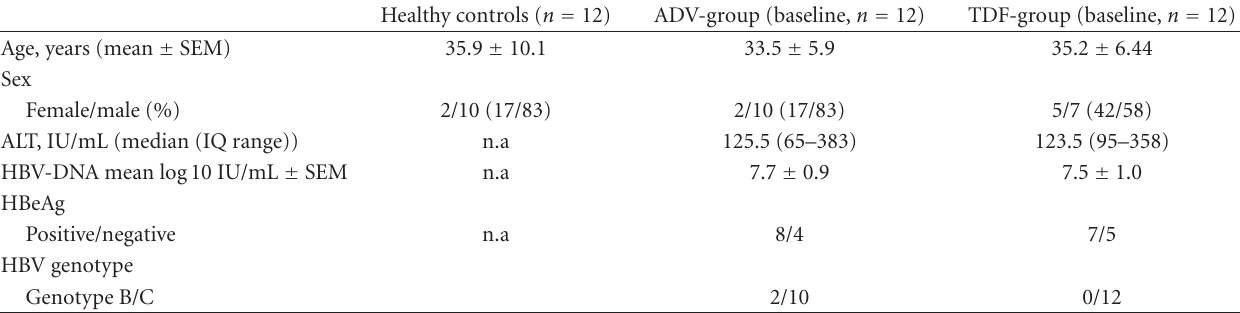
Table 1: Characteristics of study population.